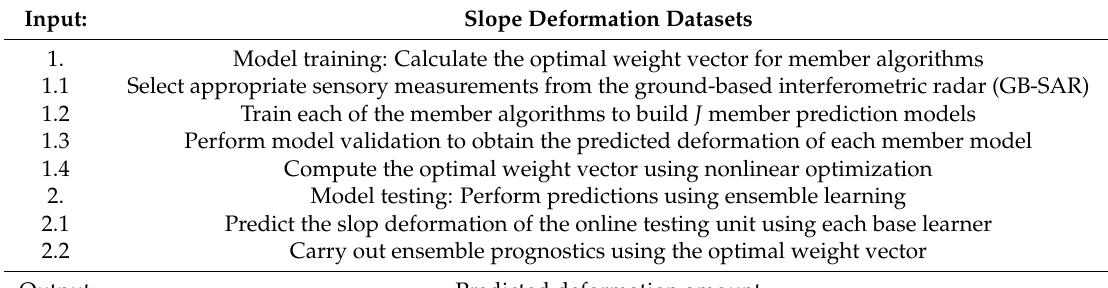
Figure 1. The flowchart of the proposed method for ensemble prediction. Where J is the number of member algorithms and w is the weight vector. Table 1. A generic computational framework.